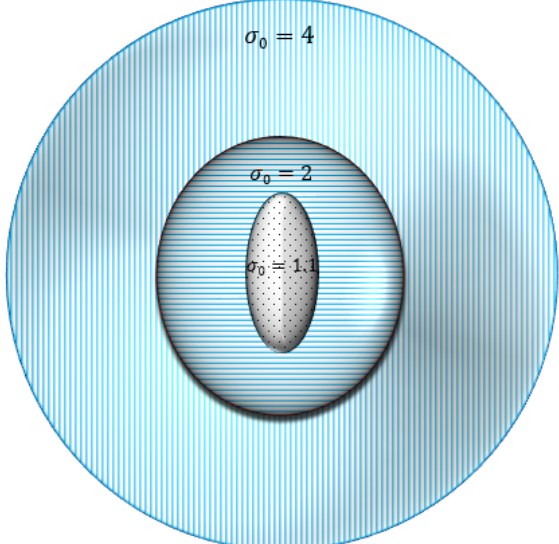
Figure 2. Ellipsoidal particles with different σ 0